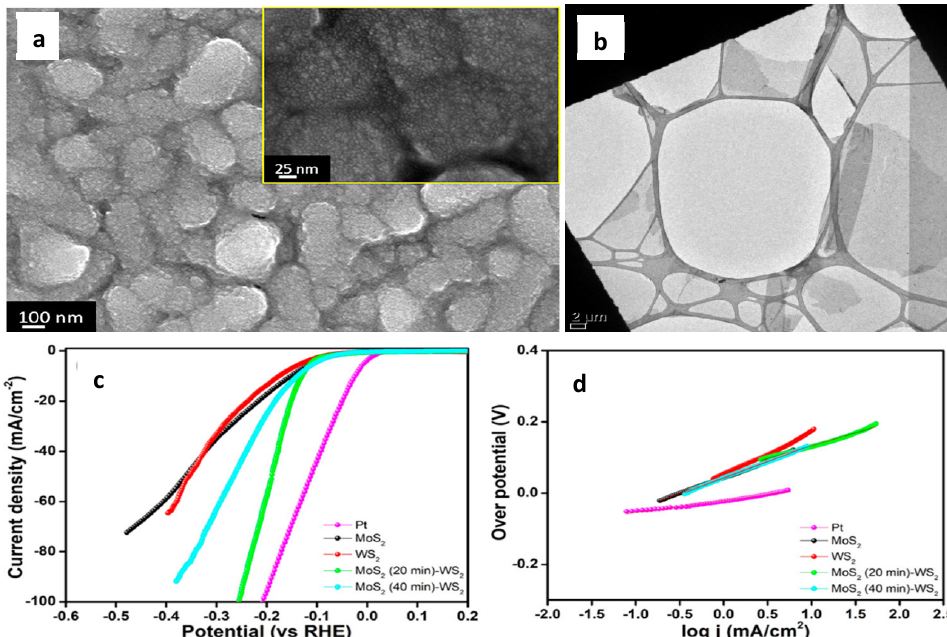
Figure 8. Characterization of MoS 2 /WS 2 heterostructure: ( a ) FESEM image, ( b ) Low magnification TEM. Electrochemical profiles ( c ) LSV with a sweep rate of 10 mV/s, ( d ) Tafel curves obtained from the polarization plots. Reproduced with permission. [142] Copyright 2018, American Chemical Society.